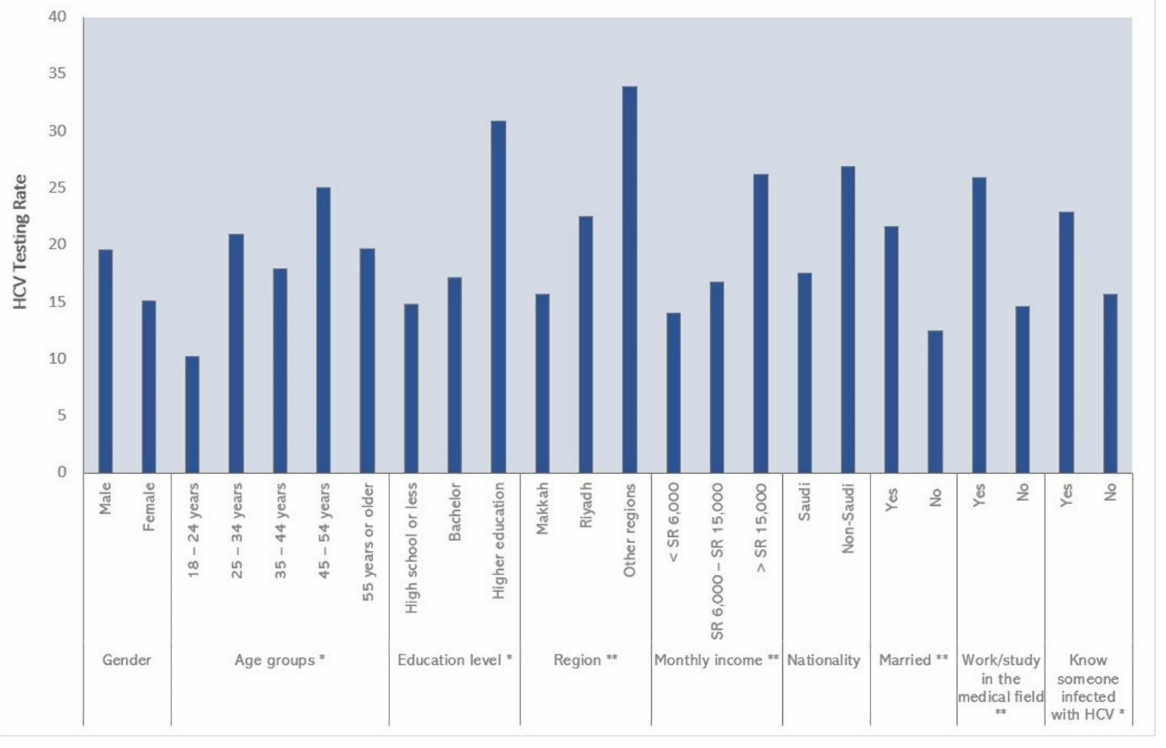
Figure 2. Self-reported HCV testing rates by the characteristics of the study respondents. * indicates significant differences with p -value < 0.05, ** indicates significant differences with p -values <